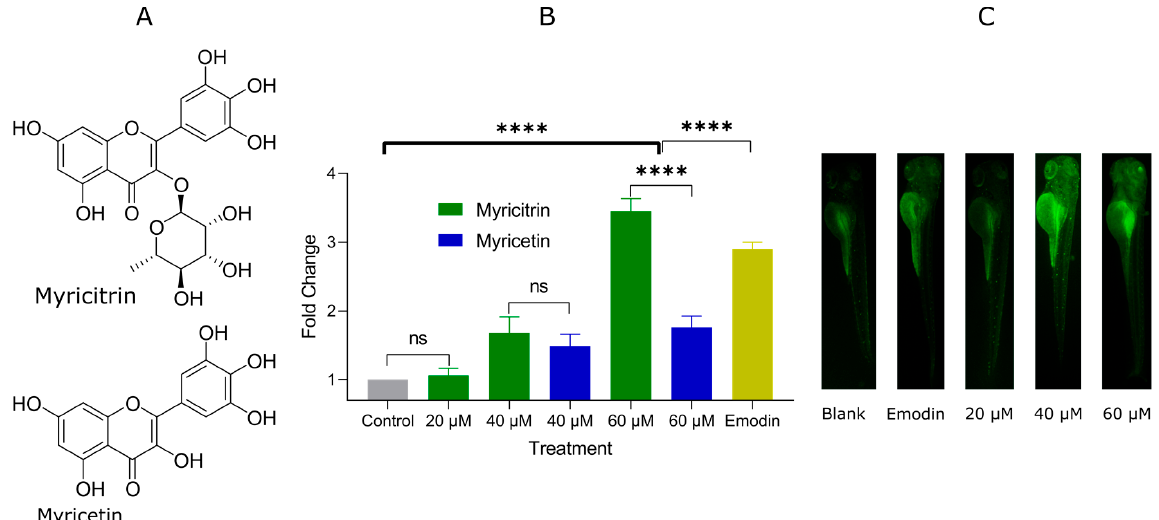
Figure 2. Myricitrin and myricetin-induced 2-NBDG uptake. ( A ) Chemical structures of myricitrin and myricetin. The structures were identified on the basis of HR MS/MS (Figure S2) and NMR spectra (Figure S3). ( B ) Fold change of 2-NBDG fluorescence measured by ImageJ (**** p < 0.001, ns, no statistical difference). The higher fold change indicates the better promotion of glucose uptake. ( C ) Fluorescent microscopy images after treatment of myricitrin and emodin.